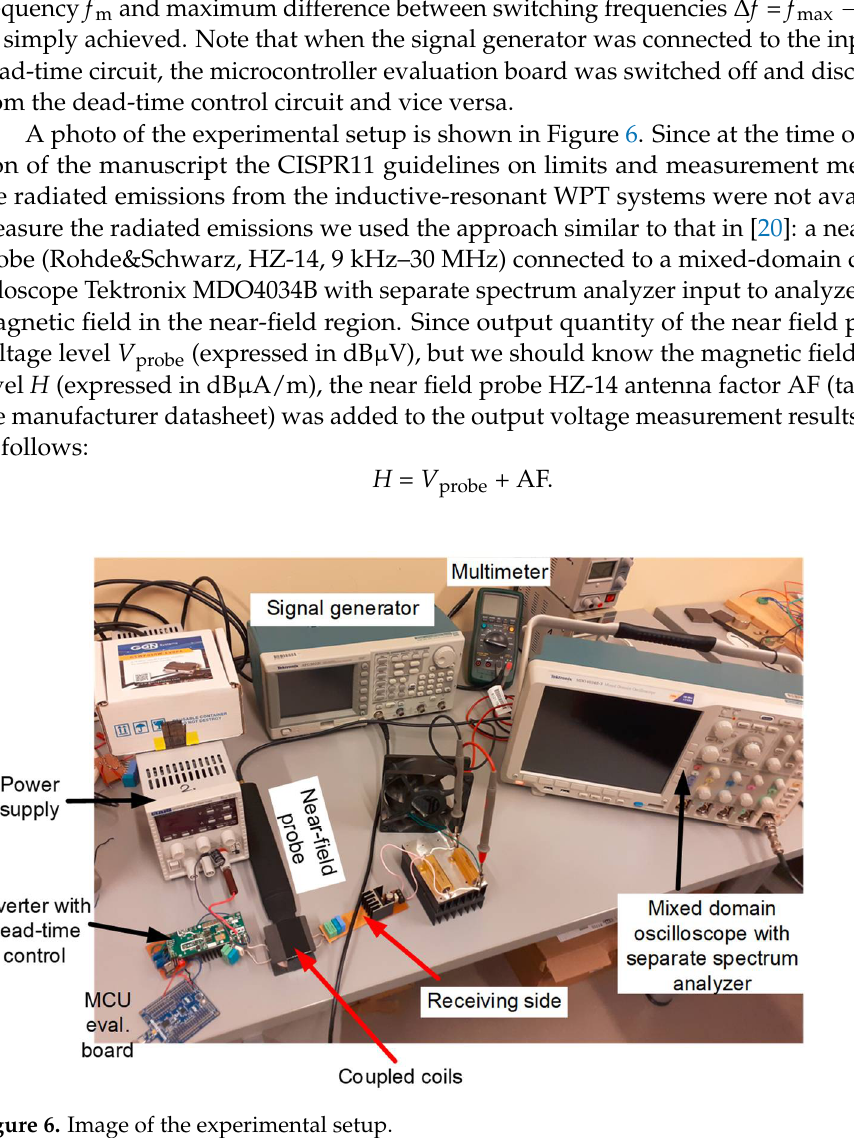
Figure 6. Image of the experimental setup.